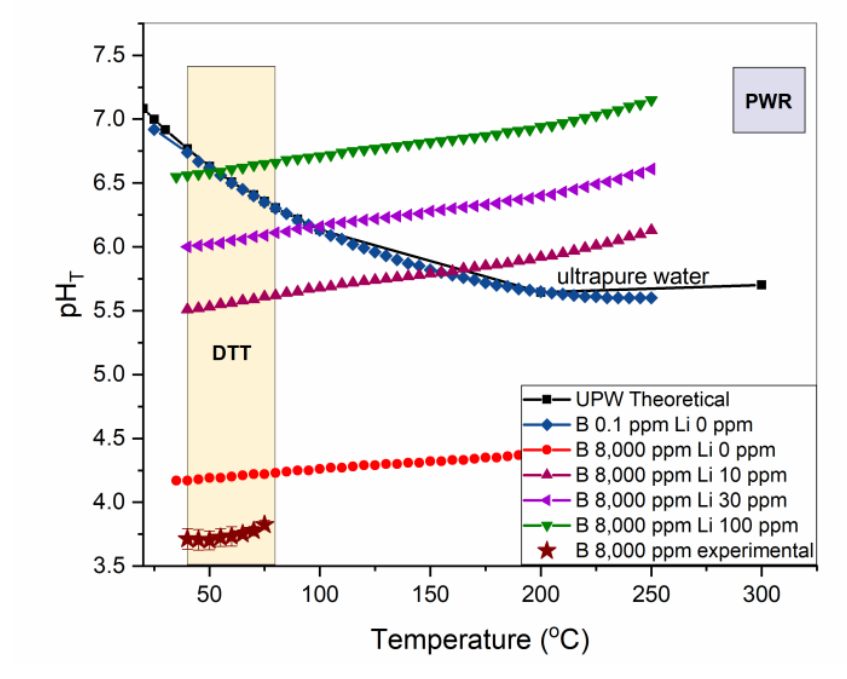
Figure 6. pH T as a function of temperature for borated solutions: ( a ) experimental data of pH T with temperature for a borated saturated solution taken from [32], the estimated pH T of borated water for DTT (8000 ppm B) and JT60SA (13,400 ppm B) are highlighted with a star. ( b ) pH T with the temperature of UPW and a borated water solution simulated with POTHY software; experimental data obtained for a 8000 ppm B solution are shown with a star (this